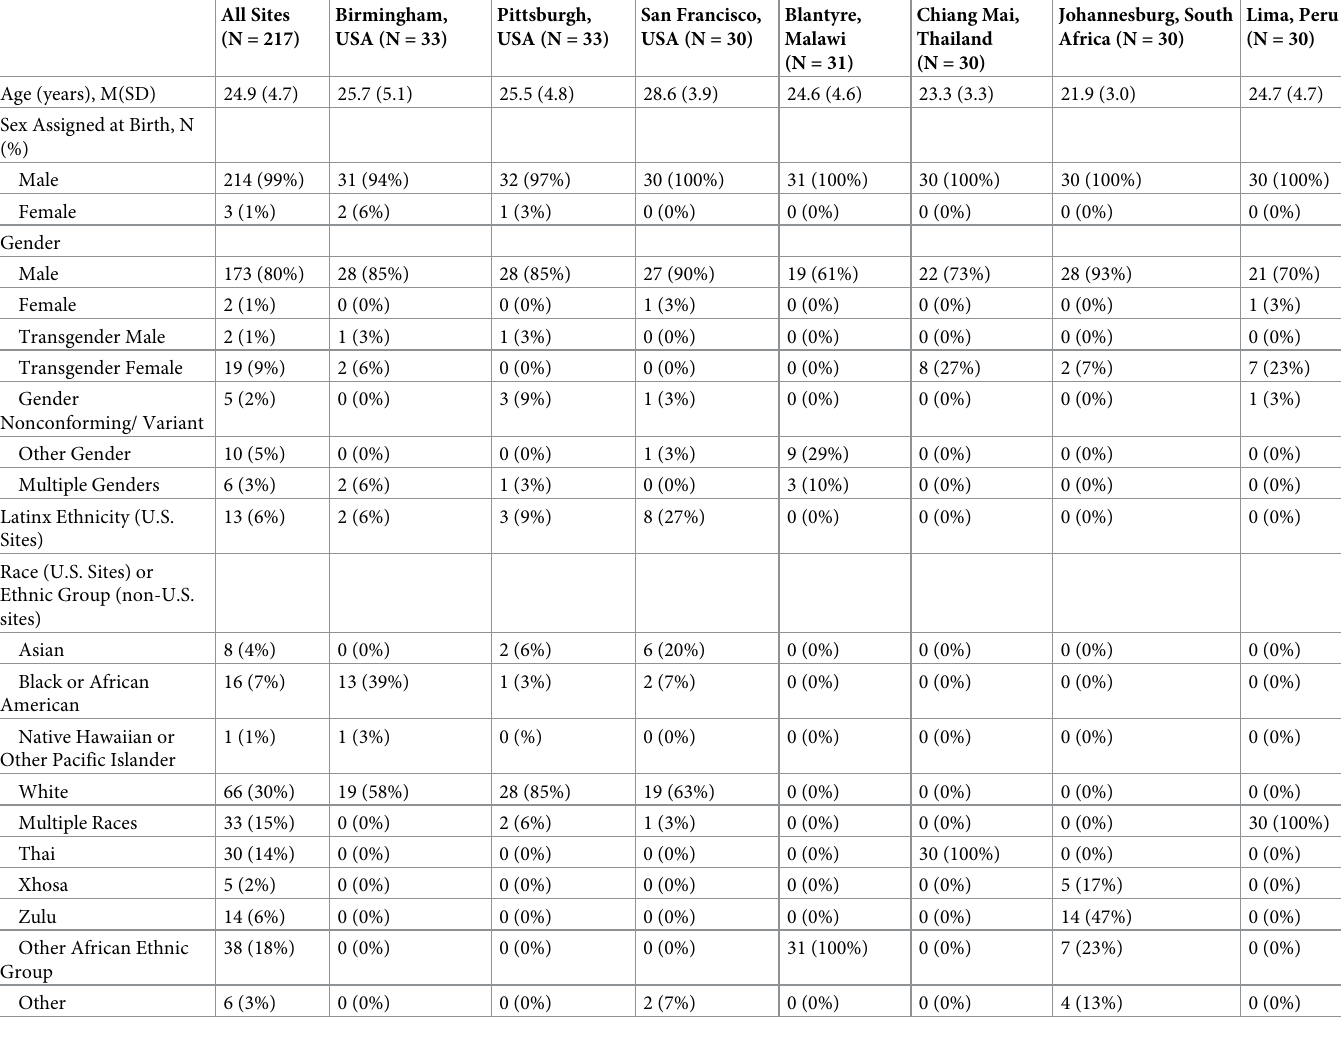
Table 2. Participants’ sociodemographic characteristics, overall and by site. All Sites (N =